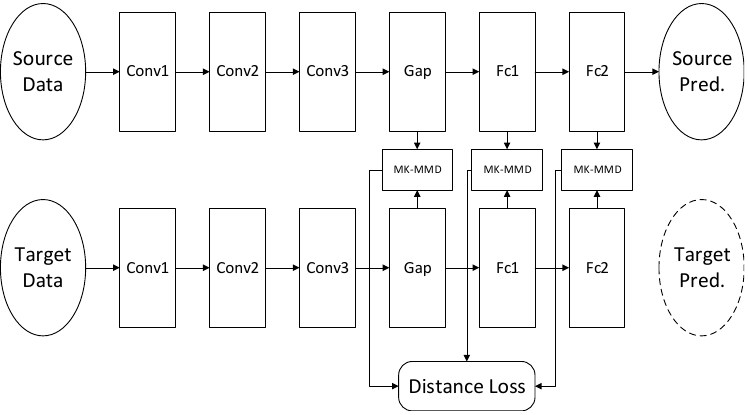
Figure 3. Application of MK-MMD